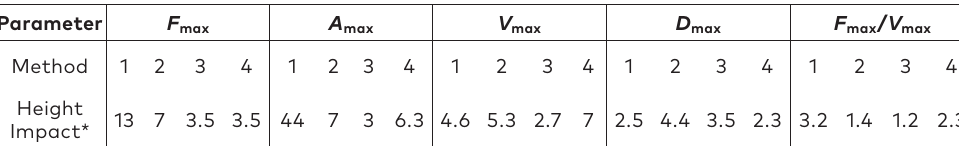
). Table 7. Impact of height on F max , A max , V max , D max and F max / V max